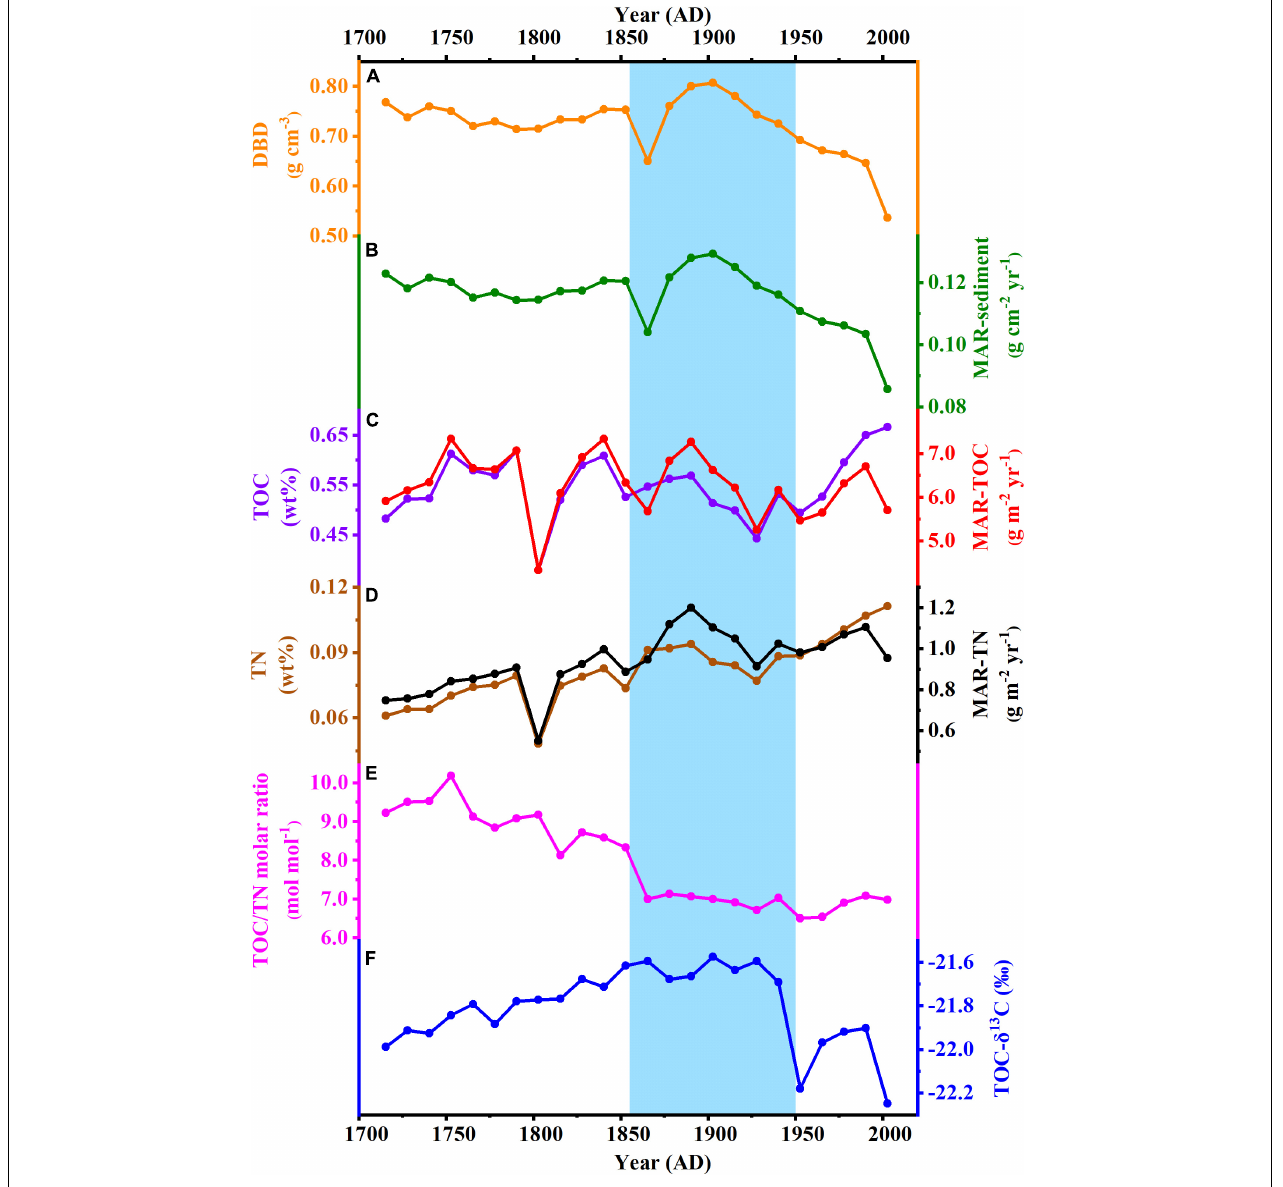
FIGURE 3 | Sedimentary records from core HH12 over the last 300 years. (A) Dry sediment bulk density (DBD). (B) Mass accumulation rate (MAR) of sediment. Sediment MAR is calculated as: MAR sediment = LSR × DBD. (C) Content (purple) and MAR (red) of TOC. (D) Content (brown) and MAR (black) of TN. (E) TOC/TN molar ratio. (F) Stable carbon isotope of bulk organic carbon (TOC- δ 13 C).